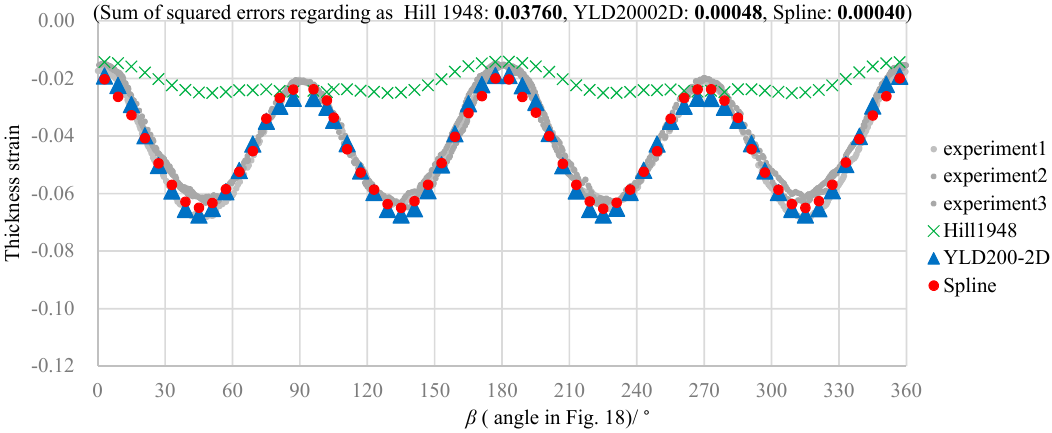
Figure 25. Comparison of thickness strain distributions on circle 1 in experiment condition D. Figure 24. Comparison of thickness strain distributions on circle 3 in experimental condition B.